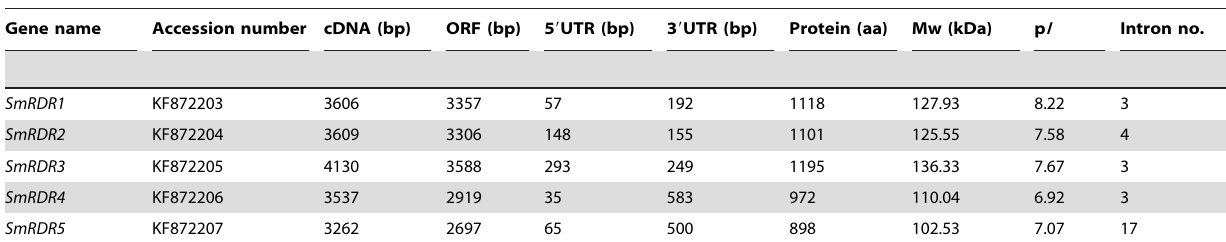
Table 1. Sequence features and intron number of SmRDRs .